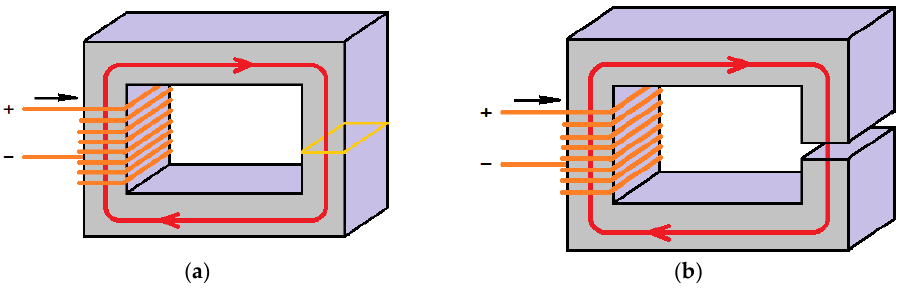
Figure 1. Examples of magnetic circuits ( a ) without magnetic resistance; ( b ) with an air gap acting as magnetic resistance.